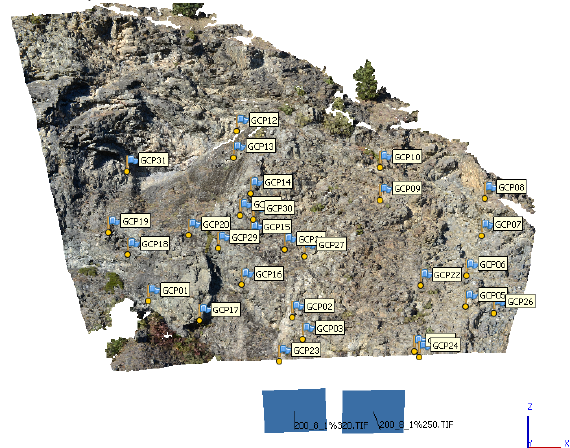
Figure 1 – The reference point cloud in RGB colours with the location of the GCP network and the two camera